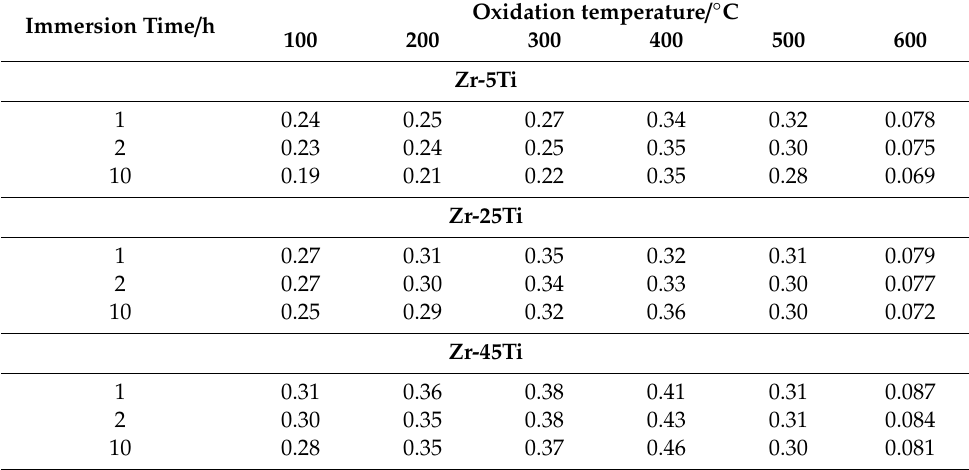
Table 6. Values of the polarization resistance (in M Ω · cm 2 ) as a function of immersion time of thermally oxidized Zr-Ti alloys in phosphate bu ff ered saline solution acidified at pH = 7.0 ± 0.1 Immersion Time / h